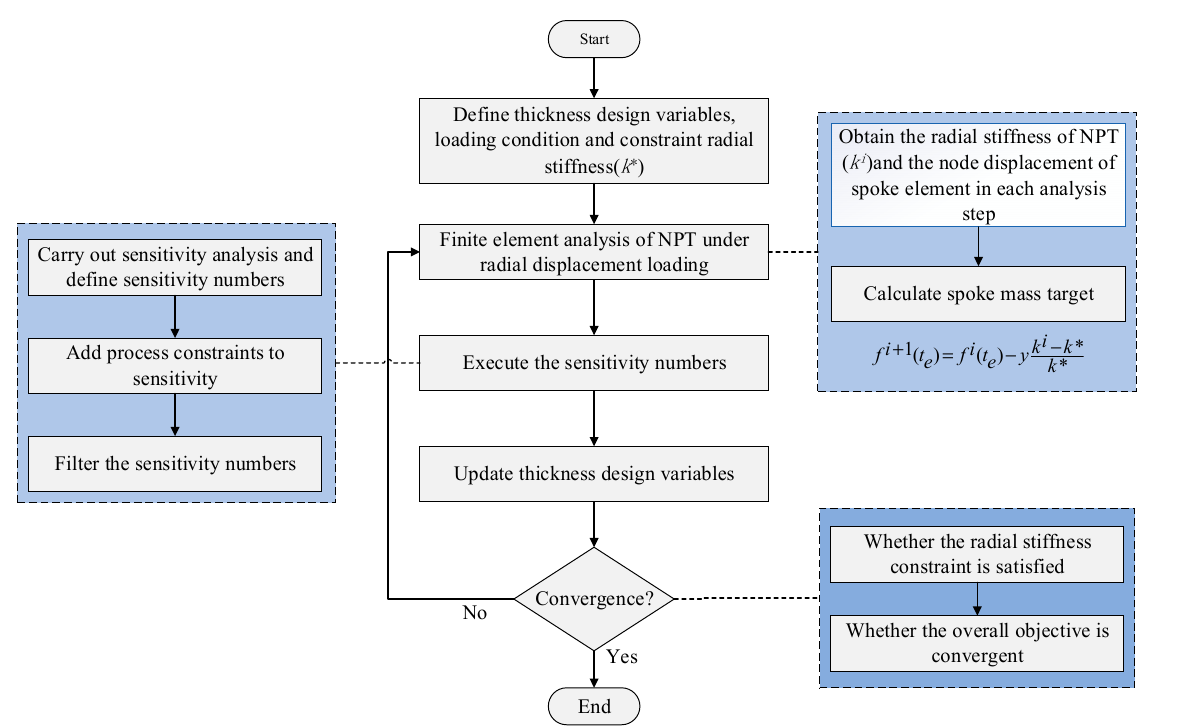
Figure 6. Flowchart of proposed variable-thickness algorithm.